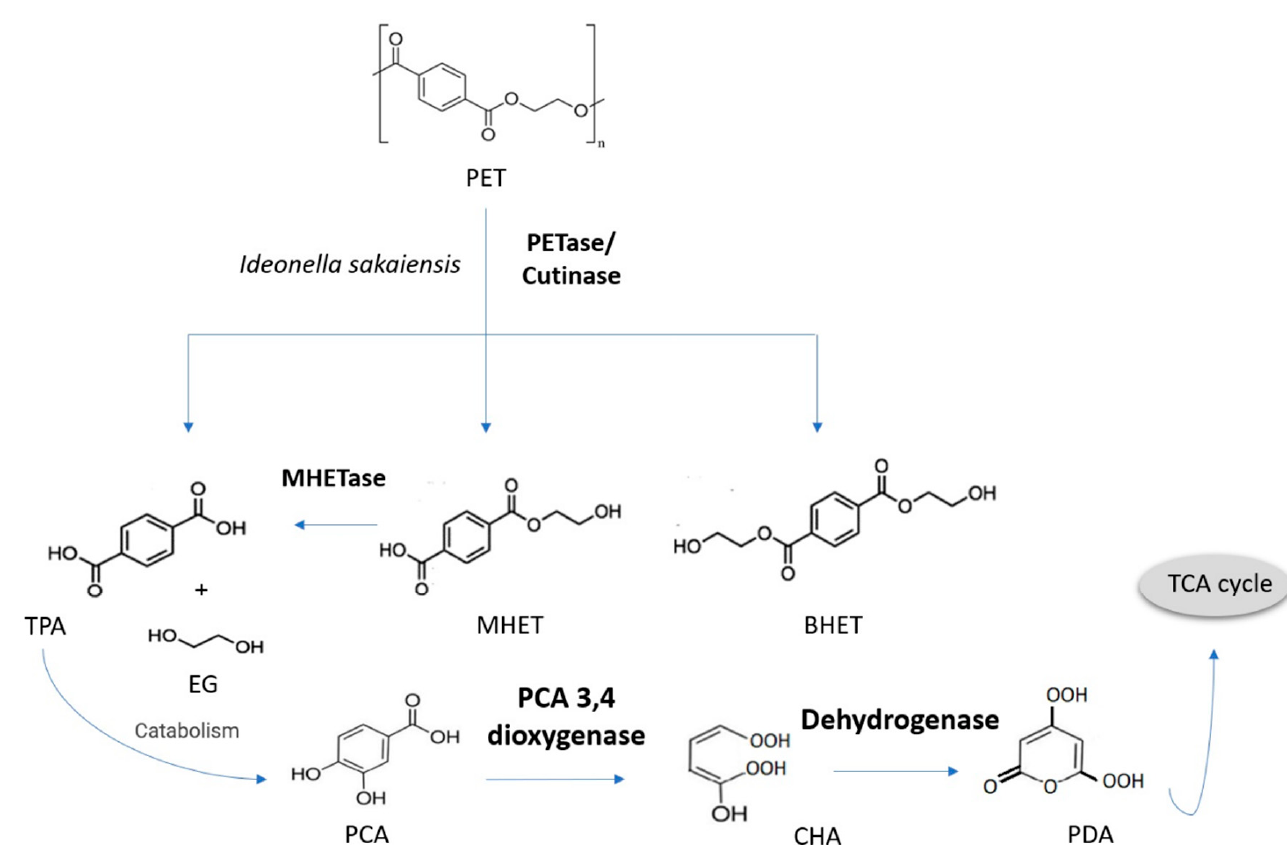
Figure 5. The microbial degradation of PET with key enzymes highlighted in bold. MHET = degrade mono-(2-hydroxyethyl) terephthalate, BHET = bis (2-hydroxyethyl) terephthalate, TPA = to tereph- thalic acid, EG = ethylene glycol, PCA = protocatechuic acid, CHA = 4-carboxy-2-hydroxymuconic acid, PDA = 2-pyrone-4,- 6-dicarboxylic acid and TCA = tricarboxylic acid cycle.